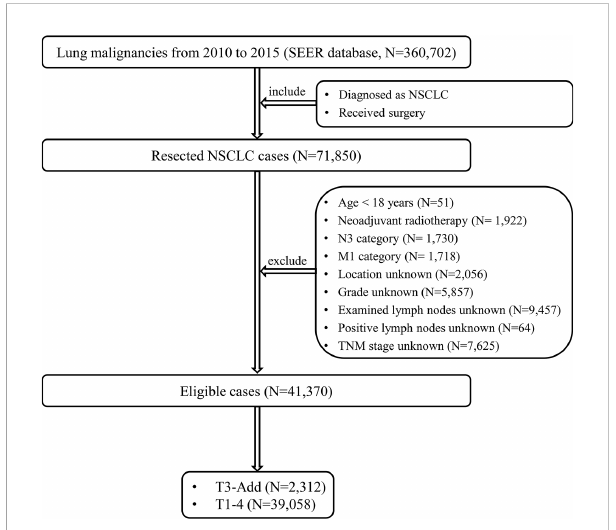
FIGURE 1 The patient selection fl ow chart. NSCLC, non-small cell lung cancer; TNM, tumor-node-metastasis; T3-Add, T3 non-small cell lung cancer with additional tumor nodules in the same